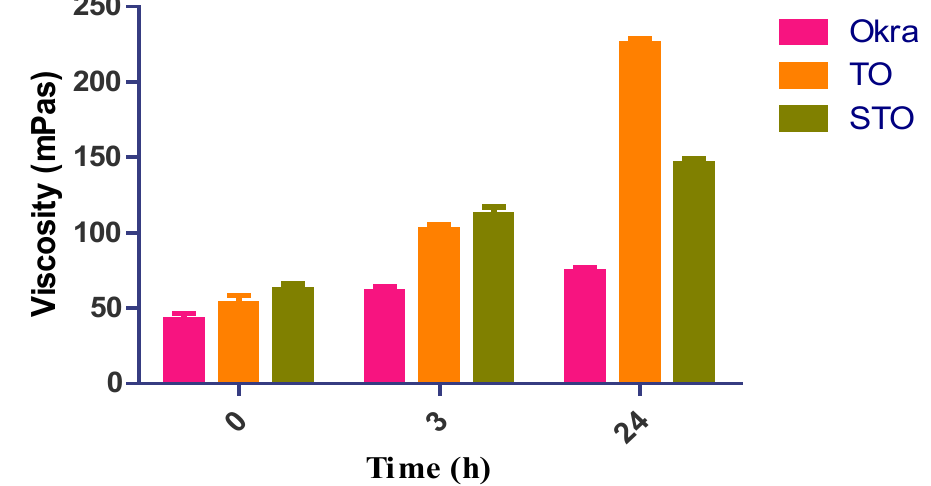
Figure 2. Rheological studies of okra gum, TO, and STO.